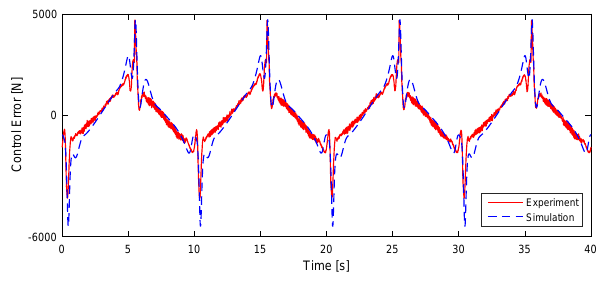
Figure 11: Variable gain characteristics utilized in Fig- ure